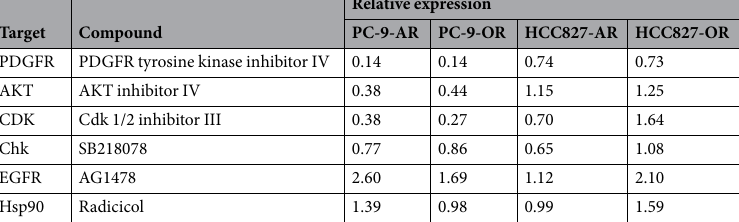
Table 2. Screening analysis using 95chemical compounds at 500 nM to clarify the candidate molecules for EGFR-TKIs-resistant cells with the SCADS Inhibitor Kit